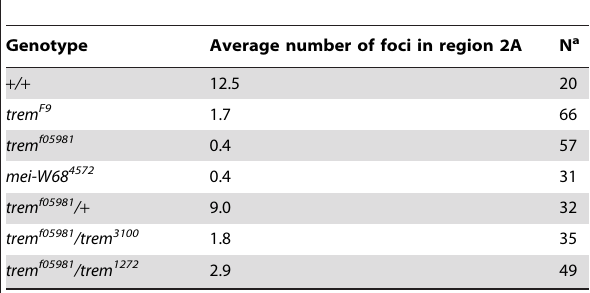
Table 4. Double strand break formation as measured by c - His2Av